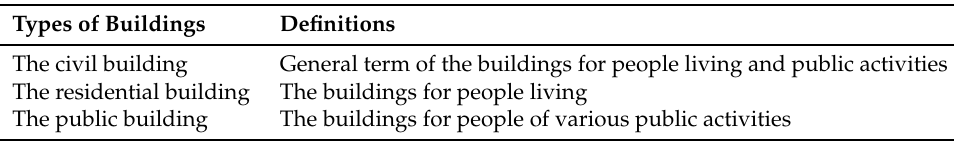
Table 2. The classification and the definitions of civil buildings in